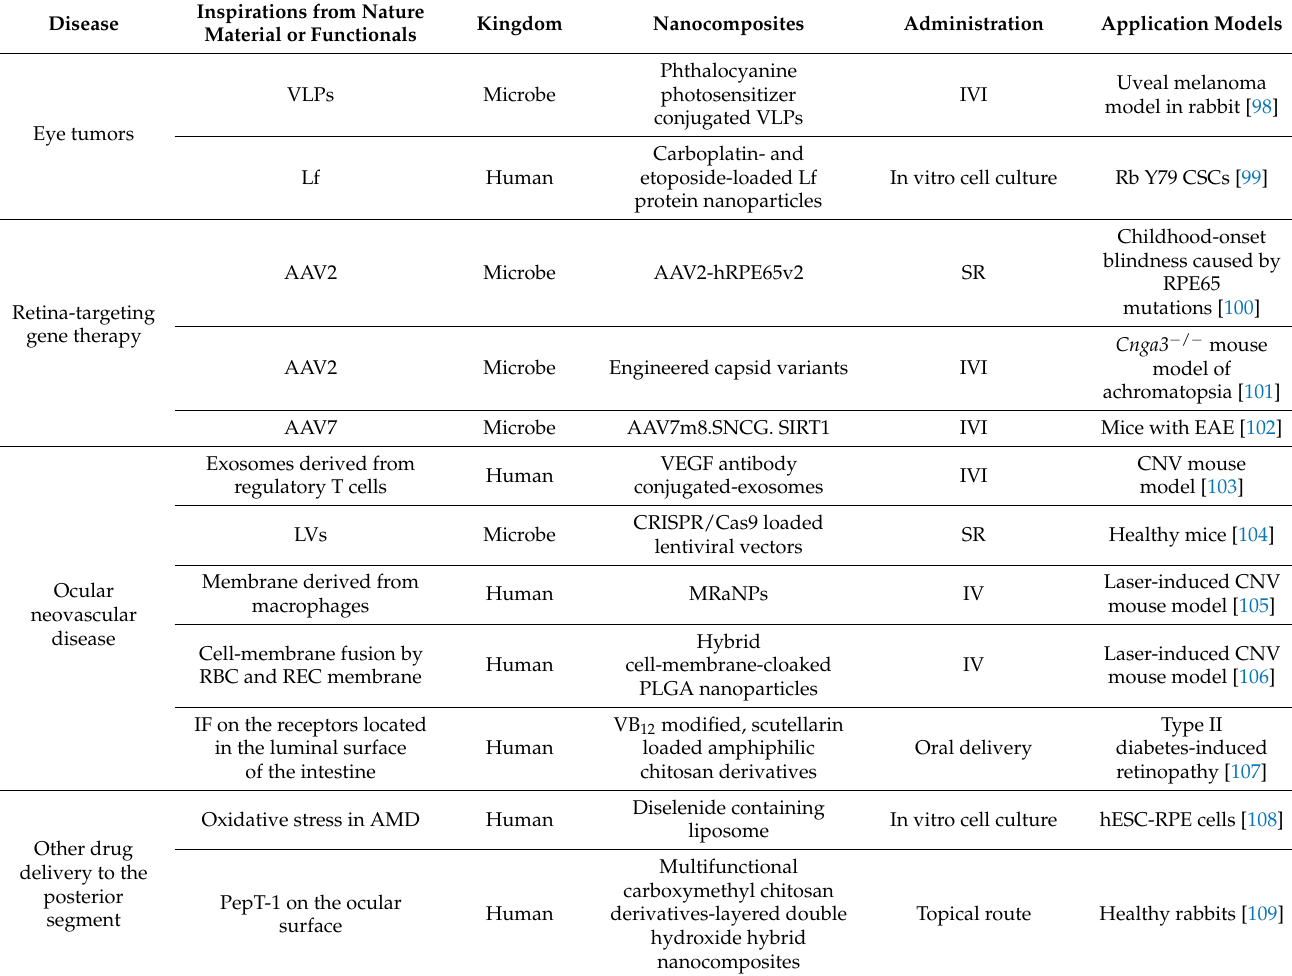
Table 3. The applications of bioinspired nanocarrier for posterior segment ocular